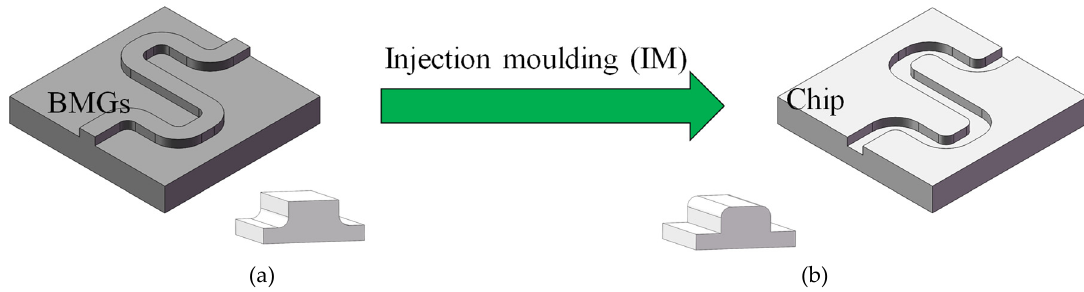
Figure 17. The inappropriate process for fabricating a microstructure on the chip. ( a ) The micro milled mold; ( b ) the obtained microstructure.